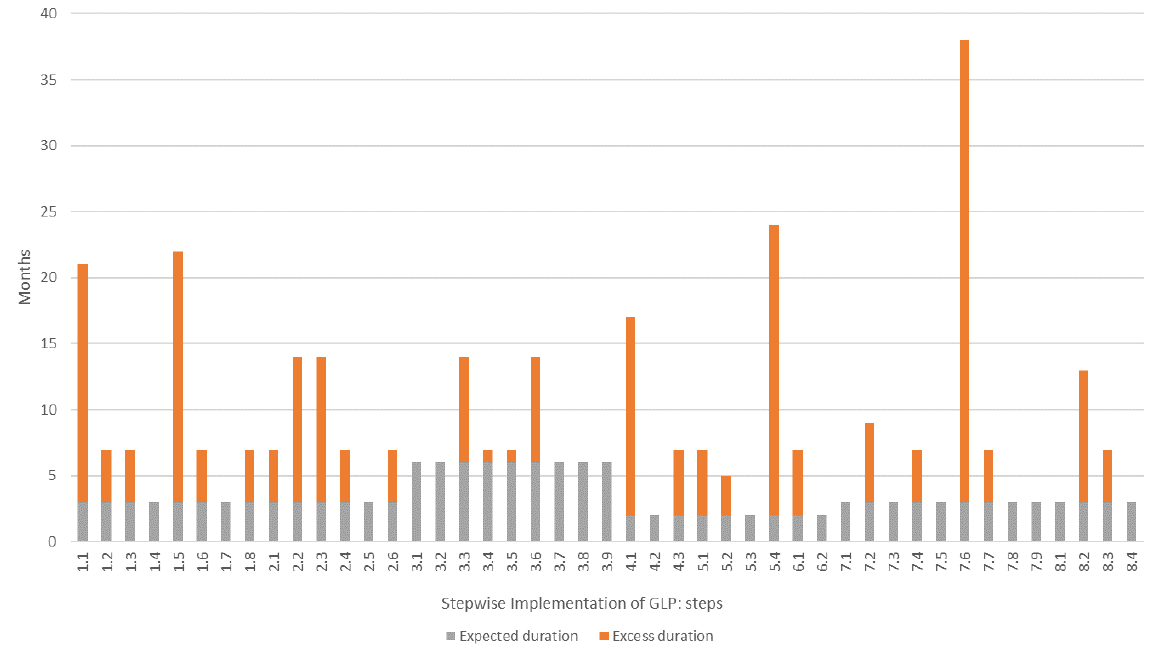
Figure 3. Additional time to complete activities required for each step in the WHO GLP Handbook. Each activity undertaken at the test facility was assigned to the step in the WHO GLP Handbook it corresponded to. The total time to complete each activity was calculated and compared to the expected duration according to the WHO GLP Handbook. The grey bars show the expected duration of each step, in months, while the orange bars show the excess time taken to complete the activities associated with that step. Five steps took over a year longer than expected. Step 5.4 (Define rules for the receipt, identification, handling, quarantine and husbandry of all test systems) and 7.6 (Formally train all staff in the use of the computer systems they need) took more than 24 months longer than expected.